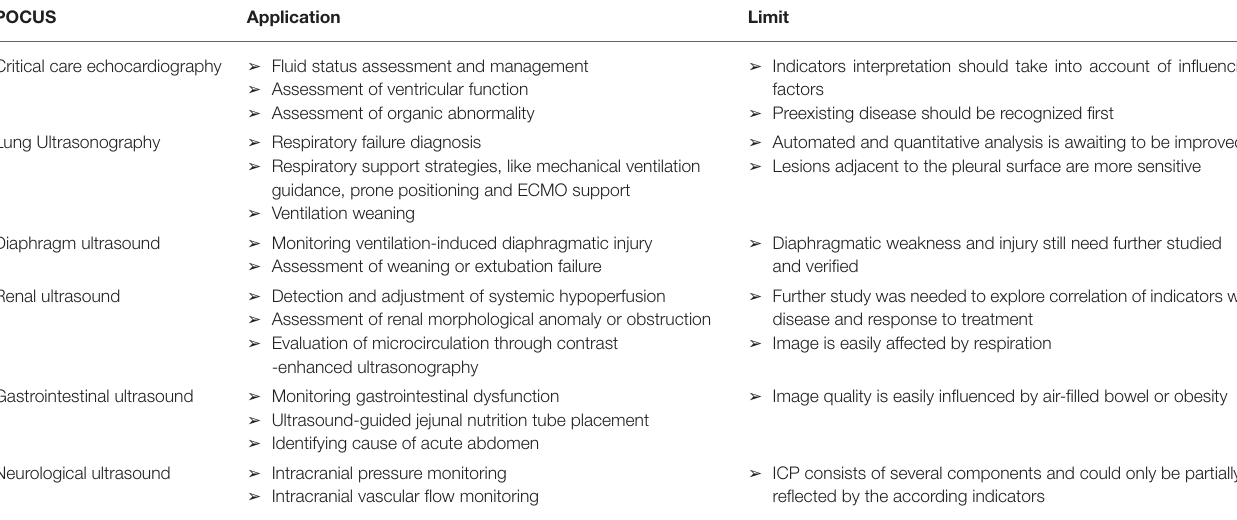
TABLE 1 | Main indications and limits of POCUS in clinical practice.